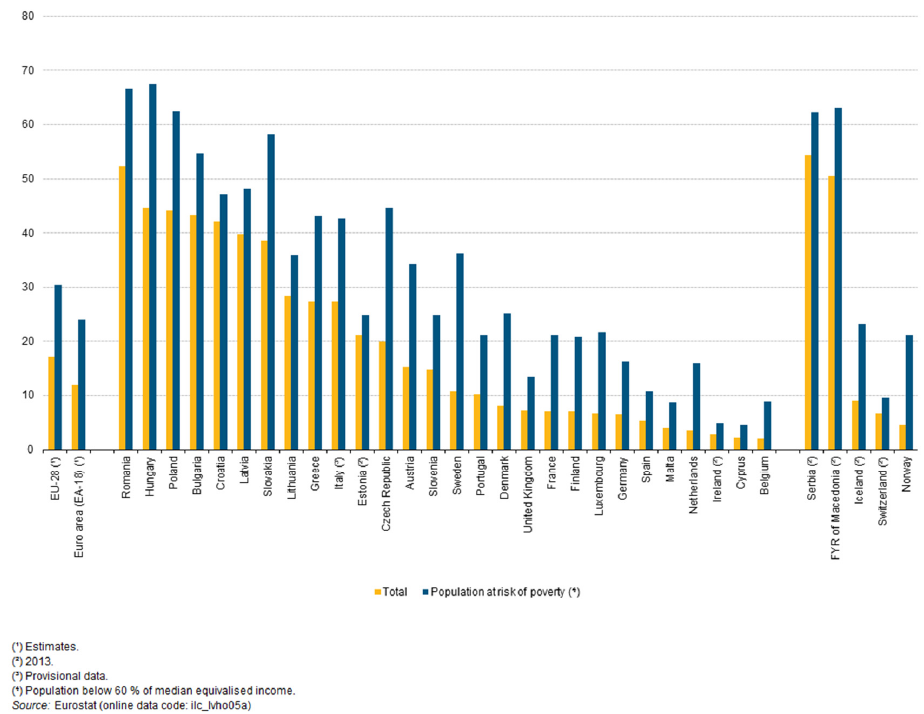
Figure 1 . Overcrowding rate, 2014, % of specified population. Source: Eurostat [50] © European Union, 1995–2013.